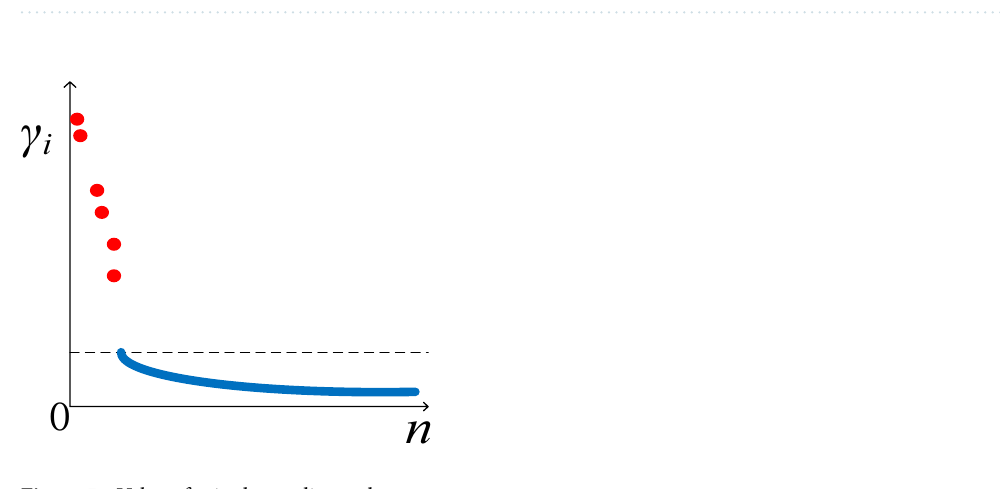
Figure 5. Value of γ i in descending